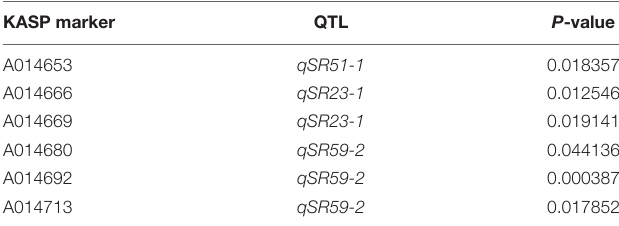
TABLE 7 | Sugarcane SNP-based KASP markers associated with smut